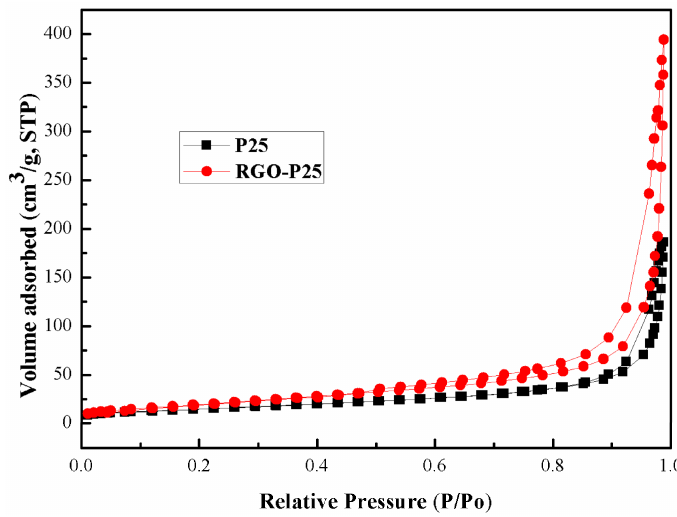
Figure 8. The BET spectra of P25 and RGO-P25 samples.